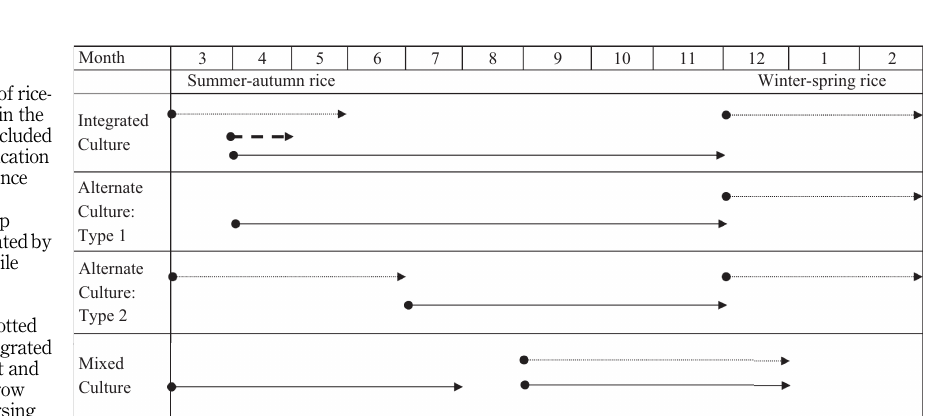
Figure 2. Rice-shrimp farming system. Shrimp shelter in the side trench during rice cultivation (a). After rice harvesting, farmers will open the inlet pipe to flood the field to allow shrimps to eat the leftovers on the rice field (b)